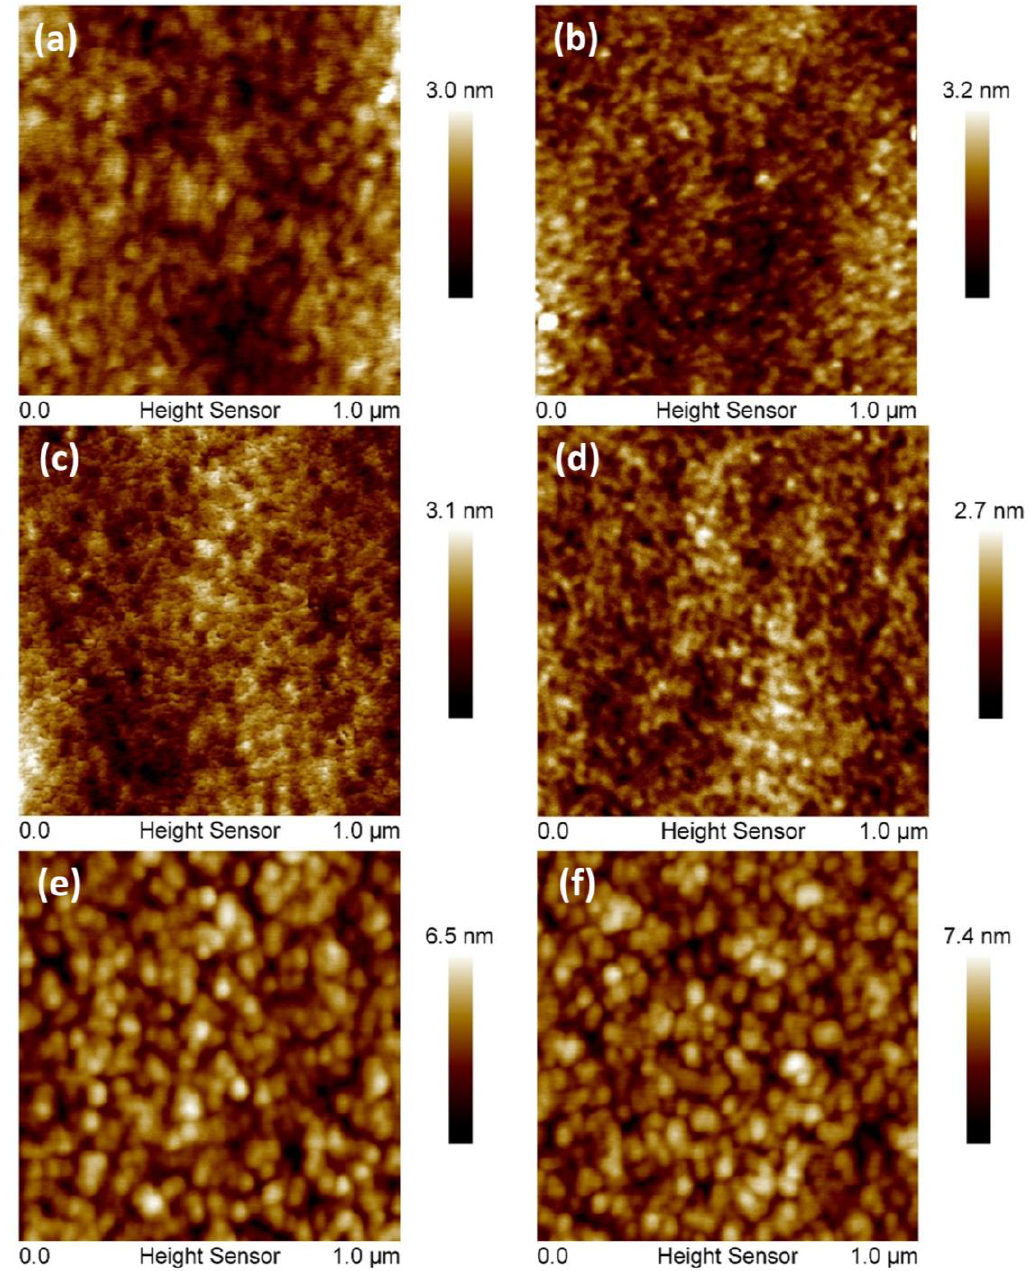
ff erent conditions ( a ) as received